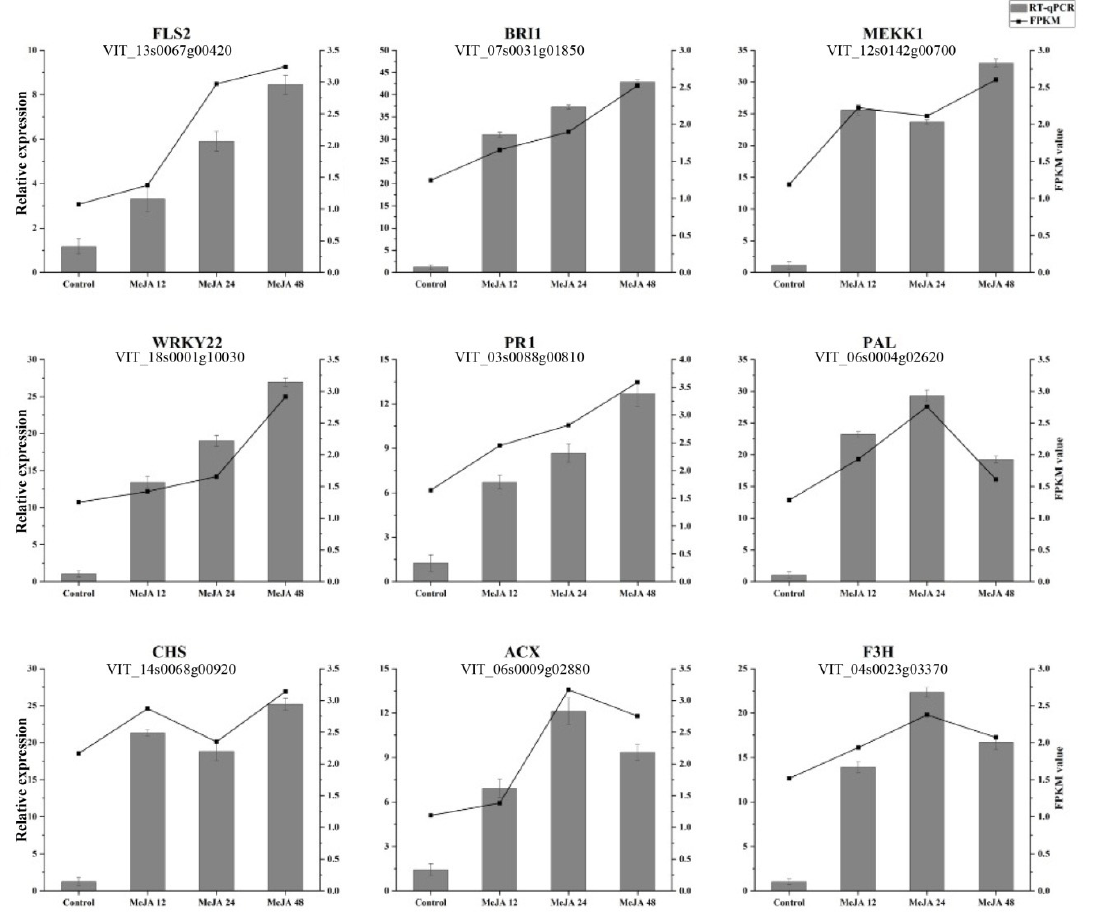
Figure 4. RNA-Seq data validation with RT-qPCR. Verification of RNA-Seq data with the expression Figure 4. RNA ‐ Seq data validation with RT ‐ qPCR. Verification of RNA ‐ Seq data with the expres ‐ level of RT-qPCR of the selected DEGs. Error bars indicate the standard error as mean + sion level of RT ‐ qPCR of the selected DEGs. Error bars indicate the standard error as mean + SD.